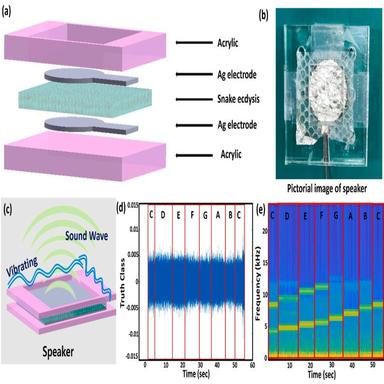
(a) The device structure of the speaker. (b) The pictorial image of the proposed speaker device. (c) The sound wave generations device structure of the proposed speaker. (d) The extracted waveform of the proposed speaker. (e) The spectrogram of the generated sound from the proposed speaker.